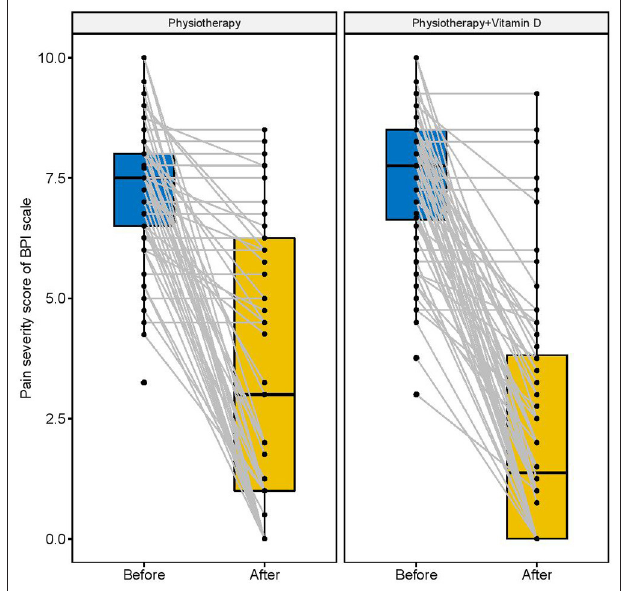
FIGURE 3 | Physical interference scores before and after the intervention.